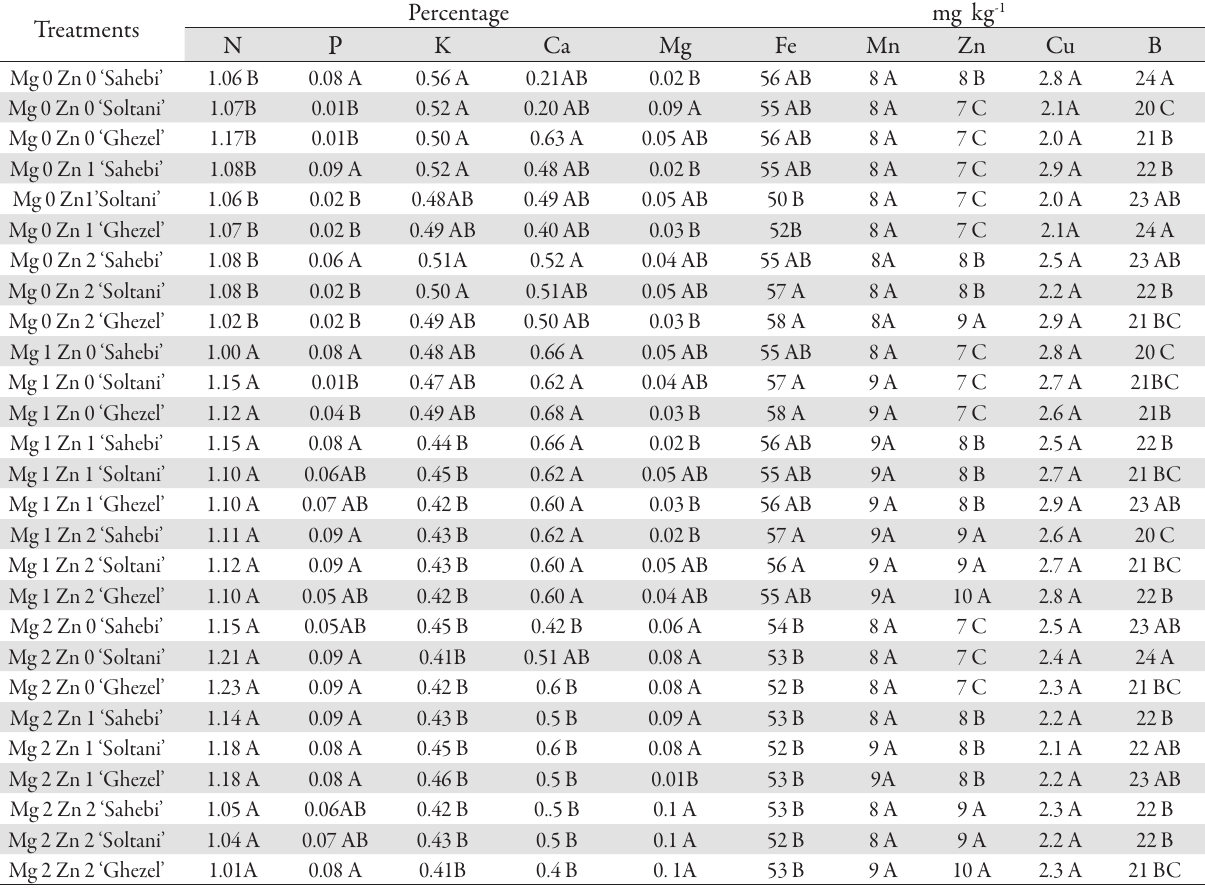
Tab. 4. Effects of various treatments on dried grape (raisin) concentrations